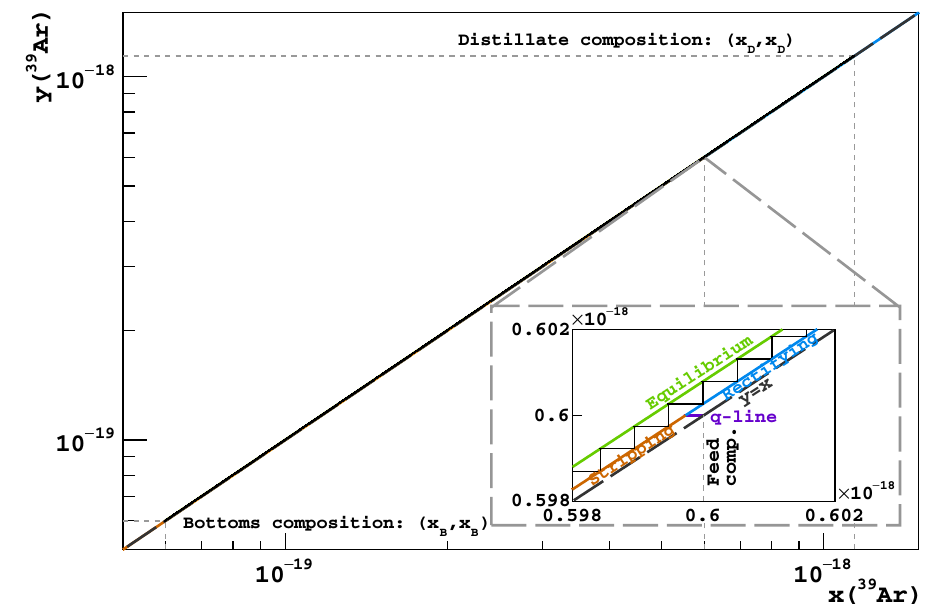
Fig. 20 McCabe–Thiele diagram for the 39 Ar– 40 Ar distillation with the input parameters of Table 2, for B / F = 50%. The insert is a blow-up of the region indicated by the shaded lines. The graphical construction starts from the equilibrium curve between 39 Ar and 40 Ar, displayed in green, in the diagram of the mass fraction of 39 Ar in the liquid phase, y ( 39 Ar ) , vs. the mass fraction of 39 Ar in the vapor phase, x ( 39 Ar ) .